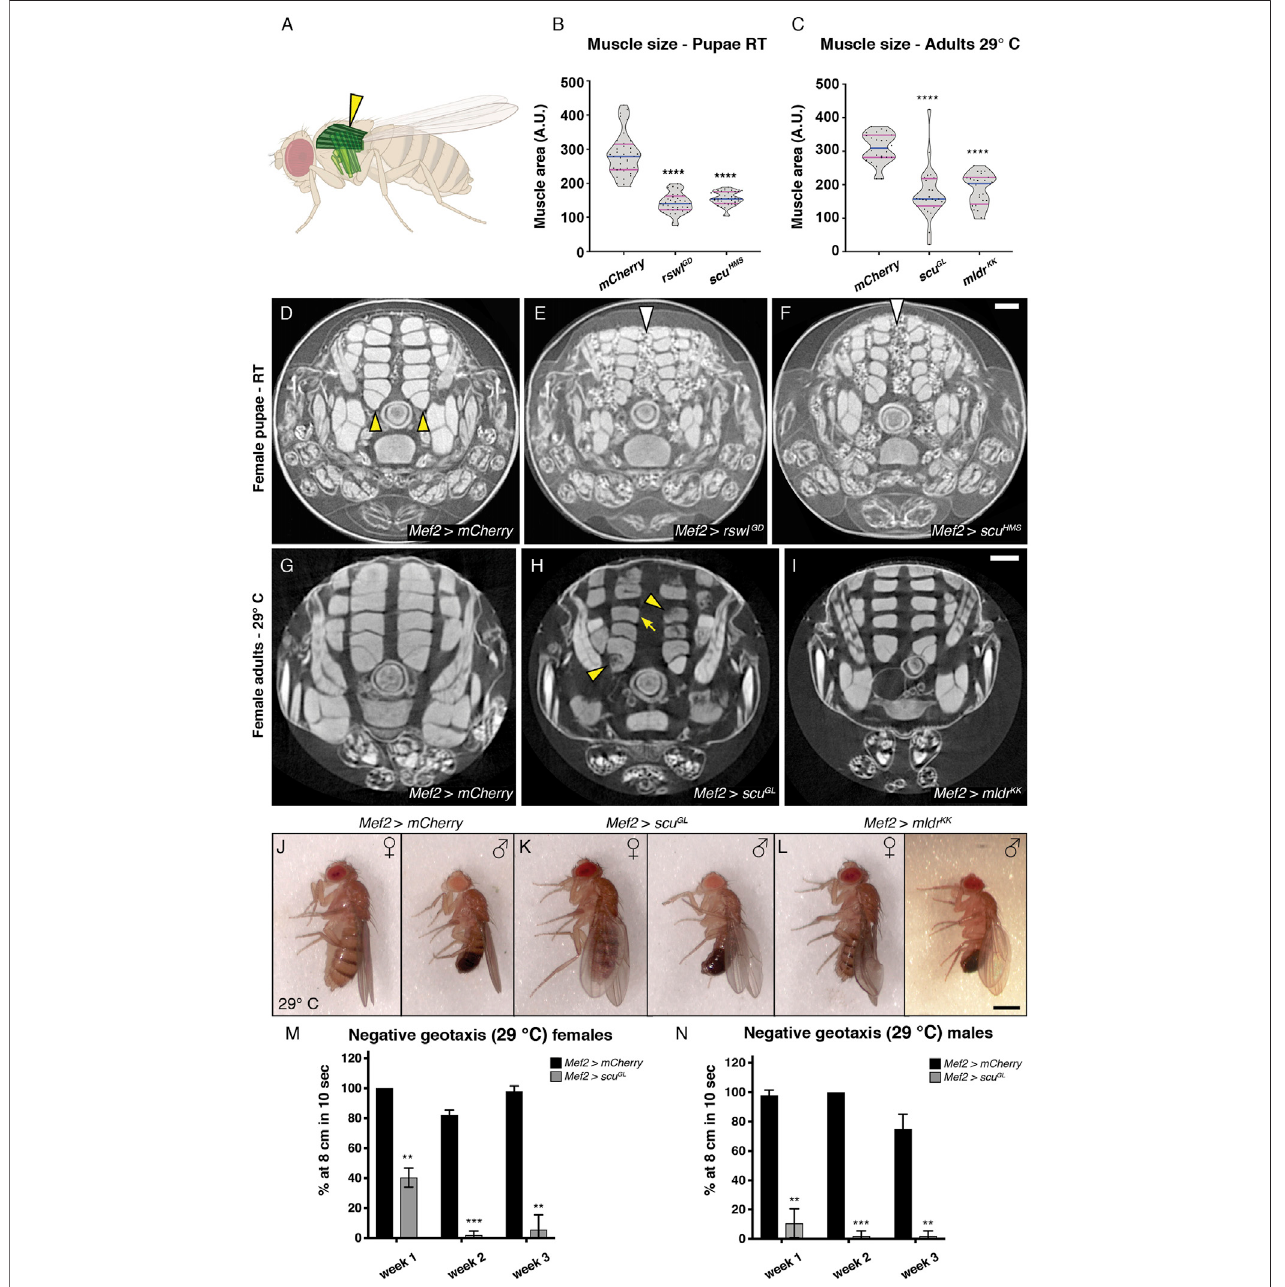
FIGURE 2 | Reduction of rswl , scu, and mldr in skeletal muscle decreases muscle size and function. (A) Fly schematic of the dorsal longitudinal muscles analyzed (darkgreenand yellowarrowhead). (B,C) Quanti fi cationofmusclesizeinfemalepupaeat RT (B) andadultfemalesat 29 ° C (C) .Each pointontheviolinplotrepresentsa singledorsallongitudinalmusclemeasuredfromacross-sectionofthreedifferentanimalspergenotype.Themedianandquartilesarerepresentedbyblueandmagenta horizontal solid lines, respectively. Further description can be found in the materials and methods. (D – F) μ CT analysis of female pupae grown at room temperature (RT) expressing rswl GD RNAi (E) and scu HMS RNAi (F) using Mef2 GAL4. The dorsal longitudinal muscles are smaller (E,F) compared to mCherry control [ (D) , yellow arrowheads]. There is also more white globular material between the muscles with RNAi [ (E,F) , white arrows] compared to control (D,G – I) μ CT analysis of indirect fl ight muscle size in adult females grown at 29 ° C. (G) Mef2 > mCherry control fl ies have intact dorsal longitudinal muscles. (H, I) Mef2 > scu GL and Mef2 > mldr KK expressing adults have smaller dorsal longitudinal muscles[arrow, (H) ]. Mef2 > scu GL adults also exhibit apparent muscle tears and gaps [ (H) , arrowheads] (J – L) Adults expressing scu GL (K) and mldr KK (L) RNAi using Mef2 GAL4display droopy andcrumpledwingscompared tocontrol mCherry RNAiat 29 ° C (J) .Fractionwithphenotype: (J) n =0/ 112females,1/76males, (K) n =54/54females,23/26males, (L) n =118/118females,19/19males. (M,N) Negativegeotaxisabilitydecreaseswithagein Mef2 > scu GL adult females (M) and males (N) at 29 ° C. (M,N) Error bars = standard deviation. Statistical signi fi cance was calculated with Microsoft Excel using a two-tailed t-test comparing Mef2 > mCherry control RNAi to each experimental RNAi to calculate p values. ** = p < 0.01, *** = p < 0.001, **** = p < 0.0001. Graphs were plotted using GraphPad Prism. Scale bar = 100 μ m in F for (D – F) and I for (G – I) , 1.25 mm in L for (J – L) .